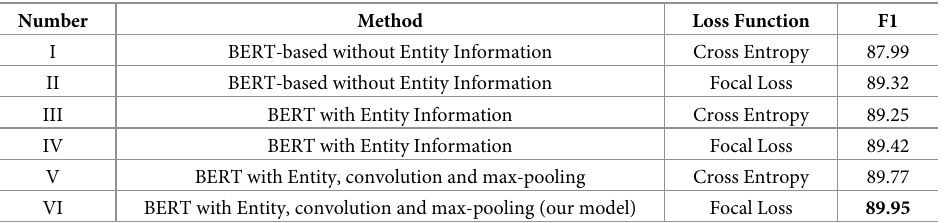
Table 6. The comparison on test results of different